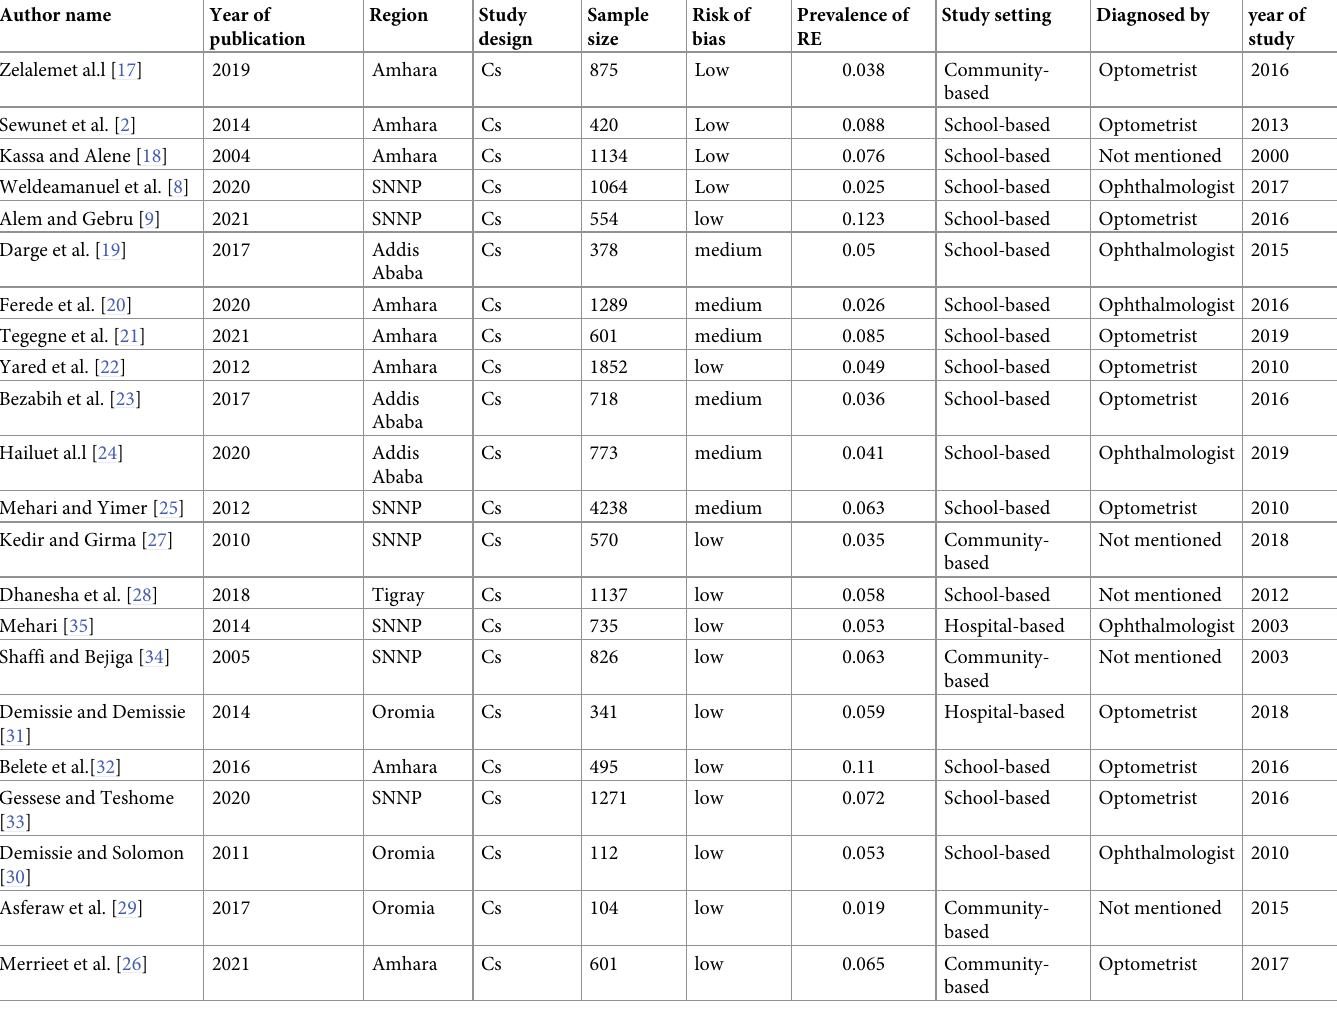
Table 1. Characteristics of included studies for the pooled prevalence of visual impairment due to a refractive error in Ethiopia,